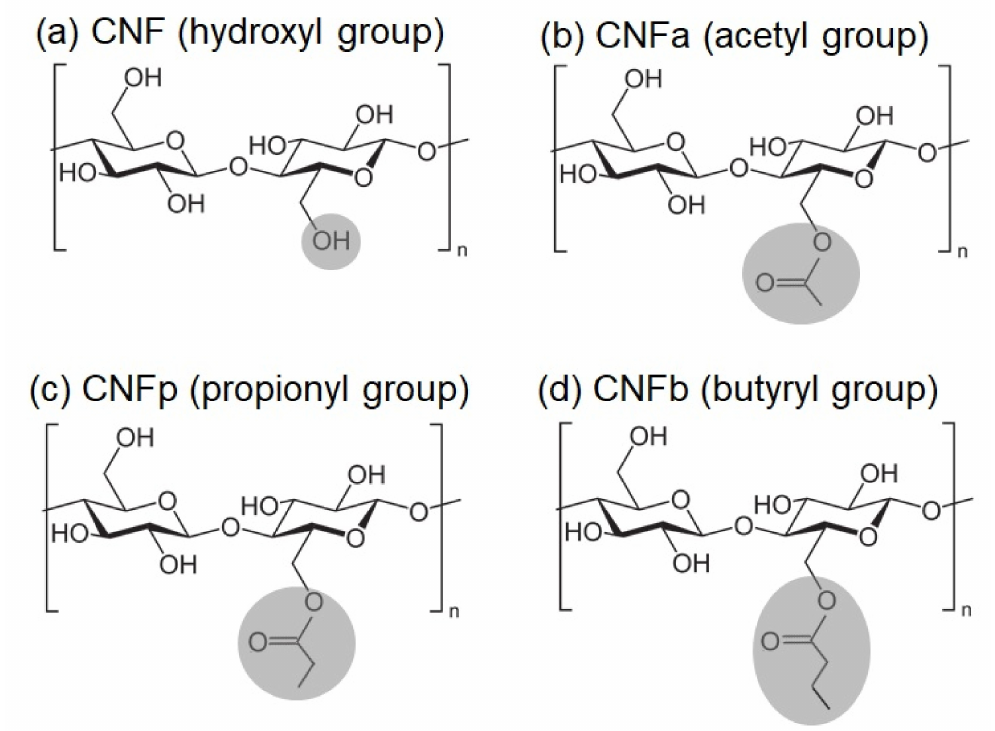
Figure 1. Chemical structures of ( a ) cellulose nanofiber (CNF); ( b ) surface-modified acetylated CNF (CNFa); ( c ) propiony- lated CNF (CNFp); and ( d ) butyrylated CNF